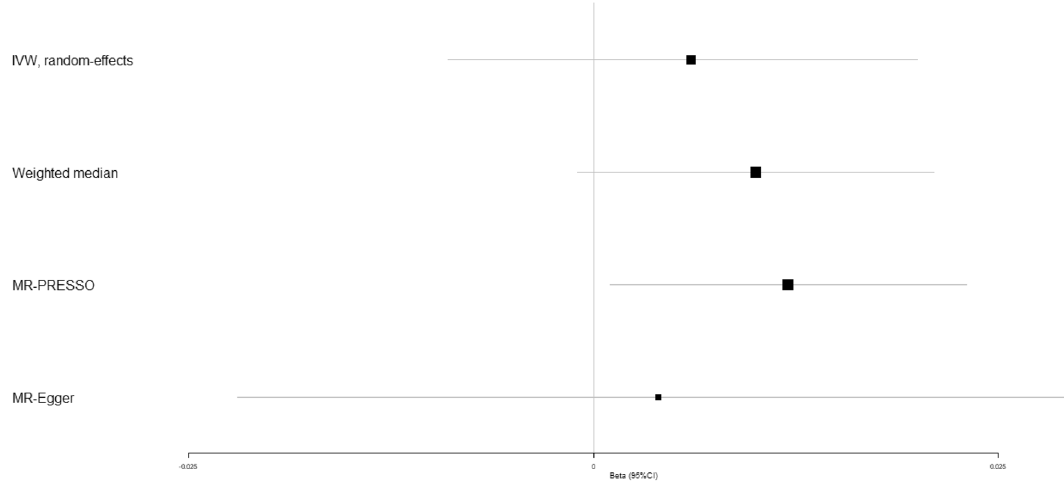
Figure 2. Beta (95% CIs) for causal influence of circulating adiponectin on coronary artery disease through multiple analyses.